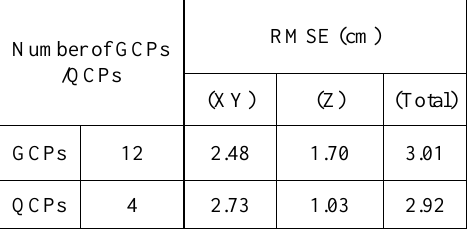
Table 1. RMSE residuals of GCPs and QCPs.